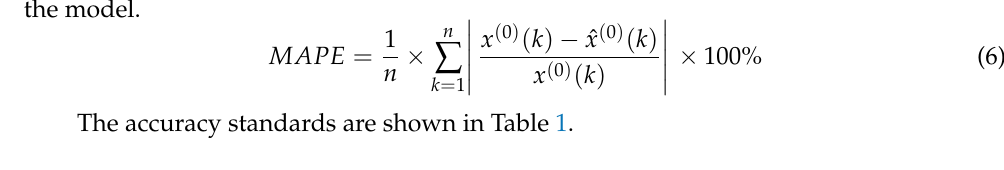
Table 1. Accuracy class. MAPE